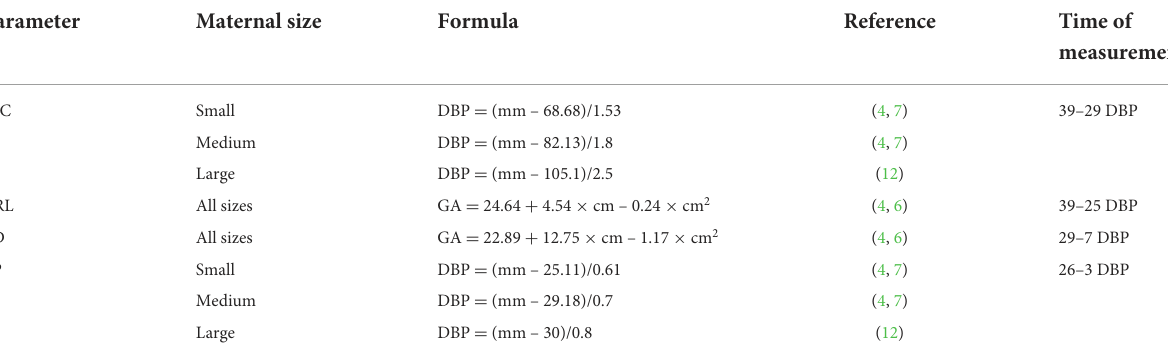
TABLE 2 Formulas for calculation of days before parturition (DBP) or gestational age (GA: days after LH peak) in bitches of different sizes (small ≤ 10kg, medium 11–25kg, large ≥ 26kg) (10–12) for the inner chorionic cavity (ICC), crown–rump length (CRL), body diameter (BD), and biparietal diameter